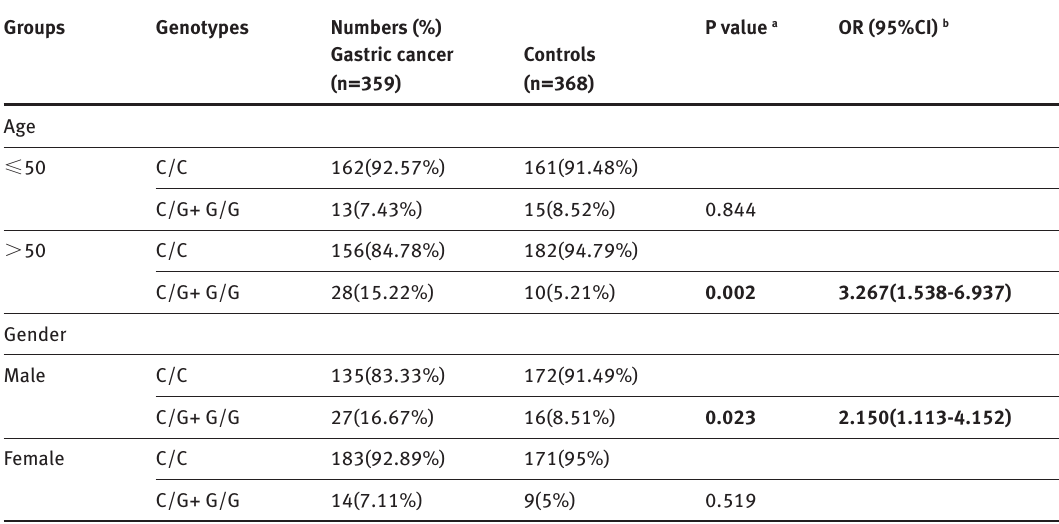
Table 3: Comparison of genotypes in CDH1 rs121964871 C>G polymorphism between gastric cancer patients and healthy controls in sub- groups classified by age and